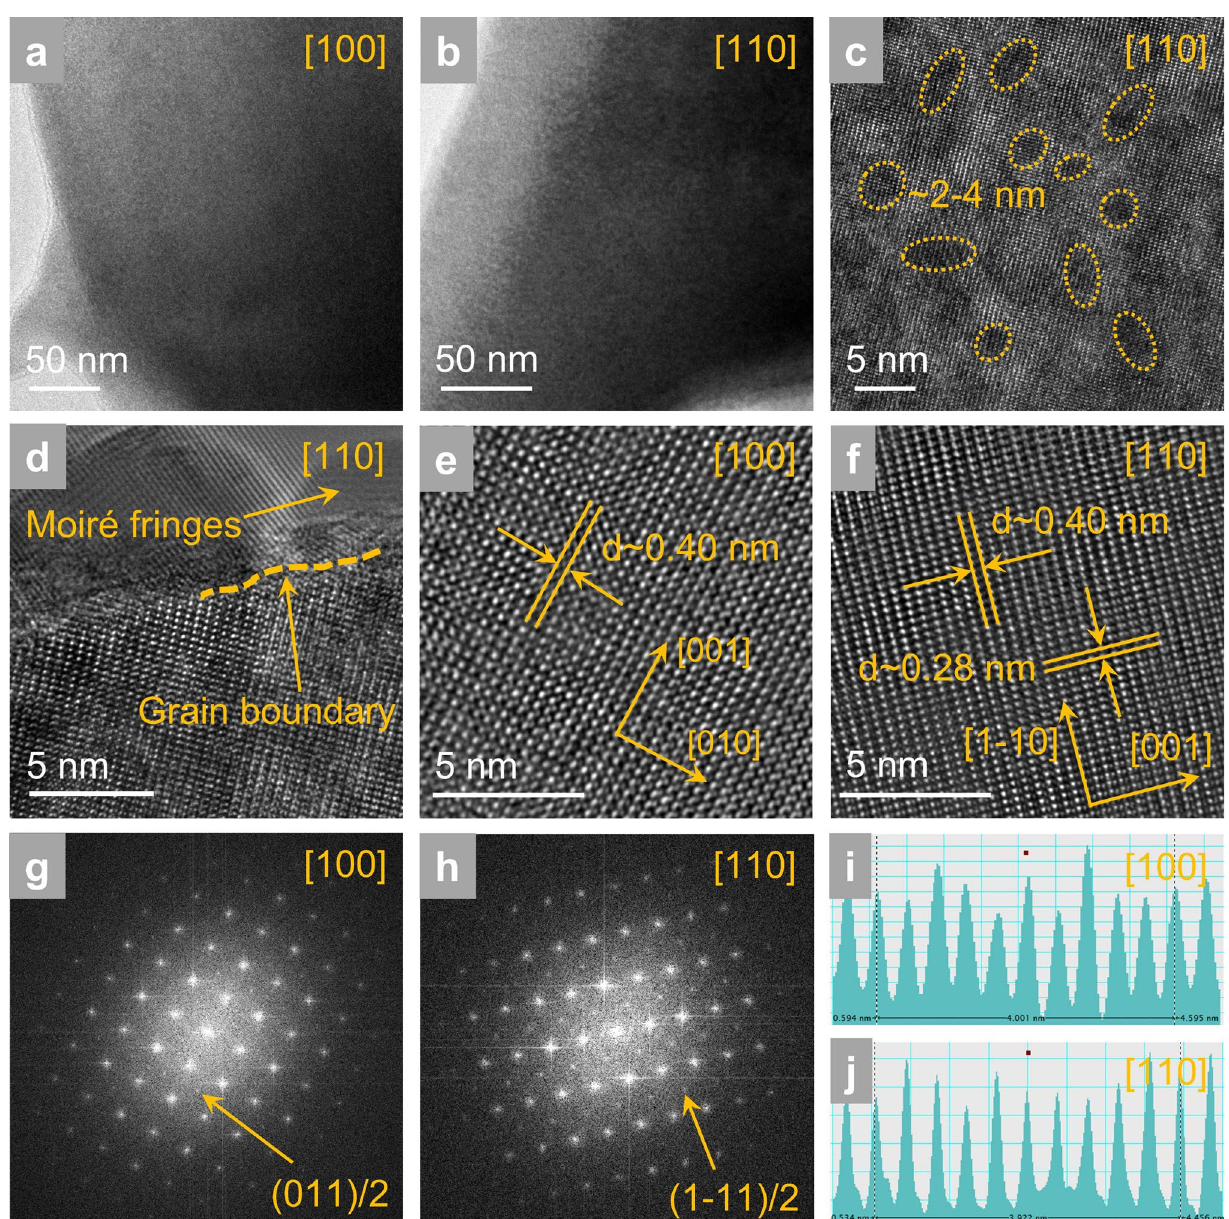
Fig. 4 Local structure for BNTFN-1/3 ceramics. TEM images of domain morphology along ( a ) [100] c and ( b ) [110] c . ( c ) HR-TEM pattern of domain morphology along [110] c . ( d ) HR-TEM pattern of Moiré fringes and grain boundary along [110] c . Lattice fringes along ( e ) [100] c and ( f ) [110] c . SAED patterns after fast Fourier transform along ( g ) [100] c and ( h ) [110] c . Atomic column intensity along ( i ) [100] c and ( j ) [110]